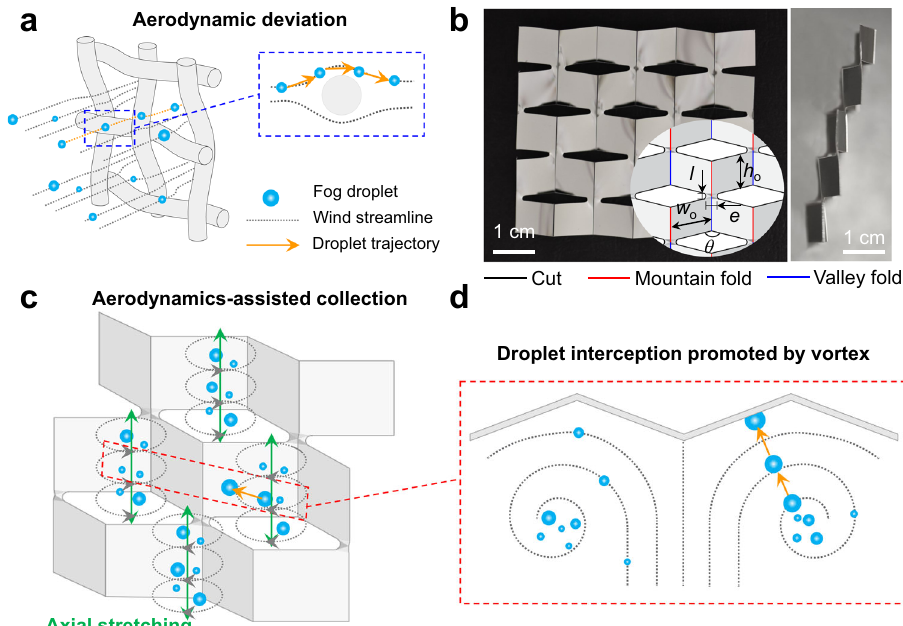
Fig. 1 The design concept. a Schematic illustration of the aerodynamic deviation problem encountered by the conventional fog collecting mesh structures. The interception of fog droplets is highly impaired by the wind streamline de fl ected around the mesh fi bers. b The front and side views of the cubic kirigami made from Al-coated PET. The insert image is the schematic showing of the cuts and folds. The height ( h o ) and width ( w o ) of cubic unit are set at 9 and 10 mm, respectively, while the width ( e ) and length ( l ) of the joint are 3 and 1 mm, respectively. The angle between two facets is de fi ned as the folding angle θ . c Conceptual drawing of the tube-like vortices penetrating through the openings. d Schematic image showing the trajectory of fog droplets recti fi ed by the vortex. The incoming fog droplets can accumulate inside the vortex, where they grow larger through coalescence and are captured by the substrate ef fi